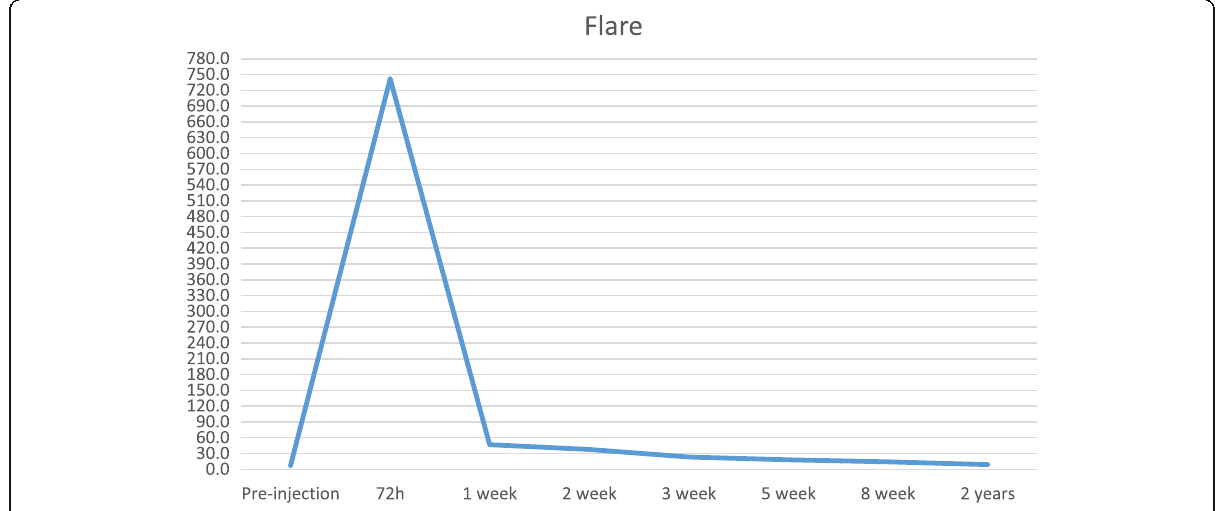
Fig. 6 Patient 2. Laser flare photometry values evolution from pre-injection values until the last